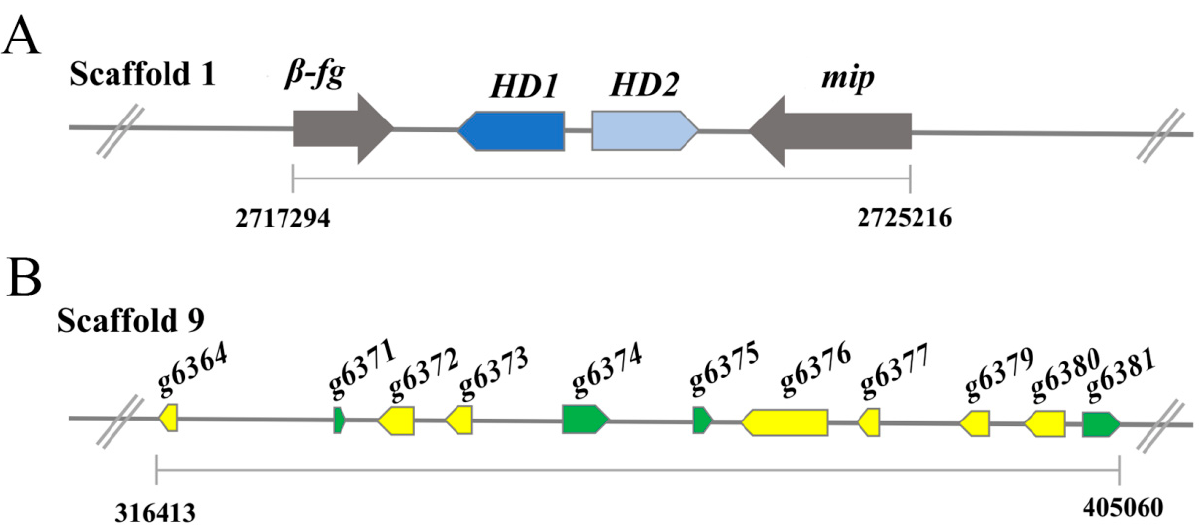
Figure 3. Analysis of the G. lingzhi MAT-A and MAT-B gene locus. ( A ) The MAT-A includes homeodomain type 1 and type 2 mating-type genes (HD1 and HD2 genes). mip : mitochondrial intermediate peptidase, β -fg : beta flanking gene. ( B ) The MAT-B locus genes encode eleven potential pheromone receptor genes.